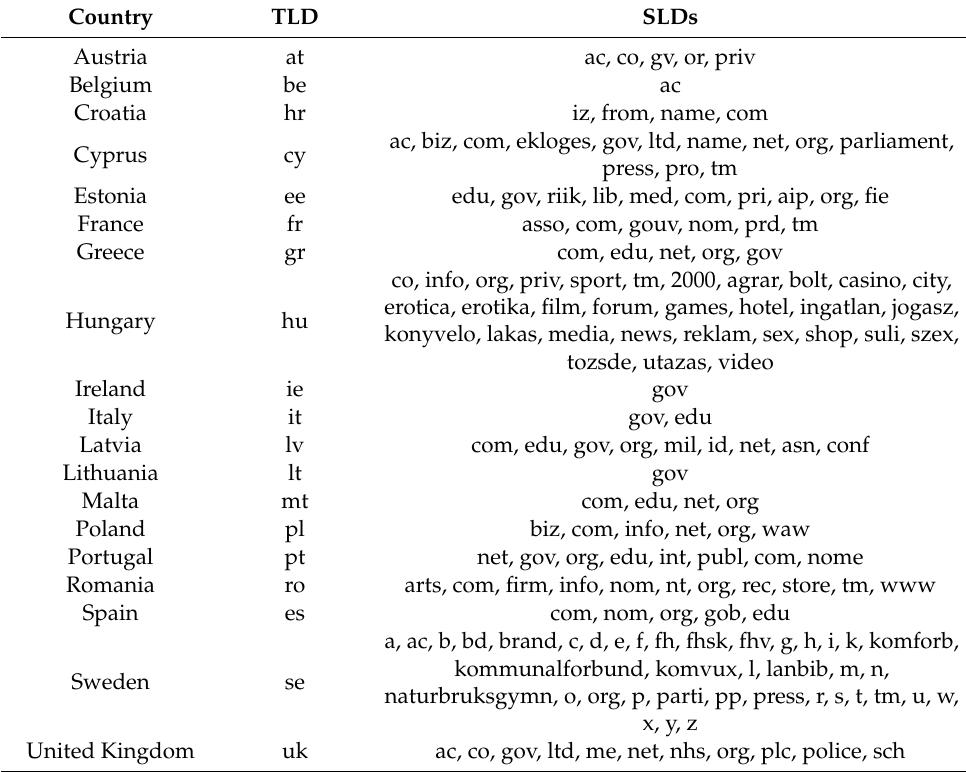
Table 1. List of TLDs and SLDs per